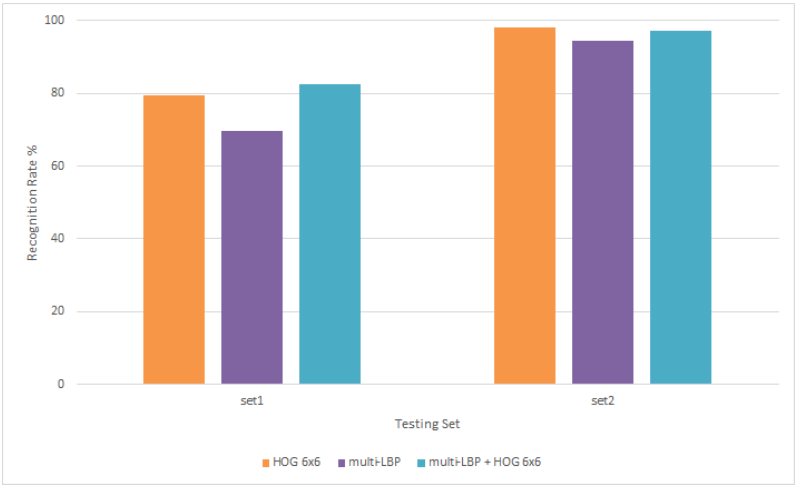
Figure 11. Results of experiments carried out by combining HOG (with a cell size of 6 × 6) and LBP.